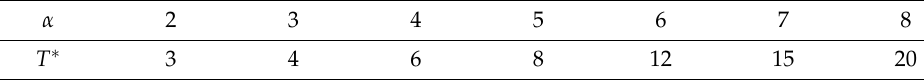
Table 2. Different α corresponds to T ∗